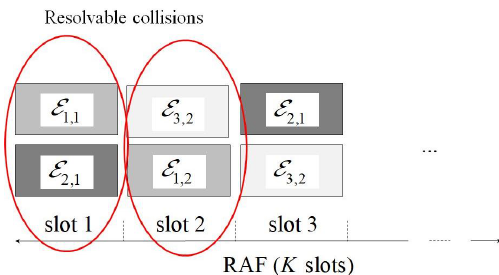
Figure 1. Protocol operation